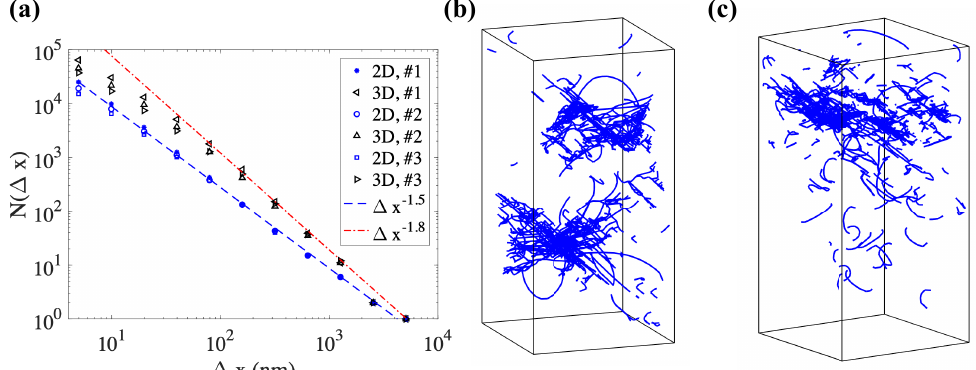
Figure 3. ( a ) Insensitivity of the fractal dimension of dislocation structure in irradiated Fe pillar with diameter 1500 nm, ( b ) dislocation configuration #2, ( c ) dislocation configuration #3.